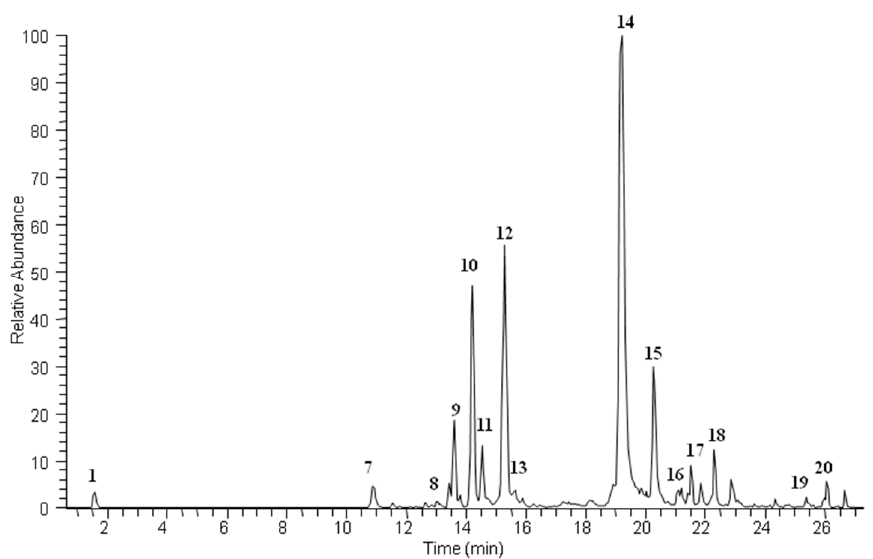
Figure 1. LC–MS profile in negative ion mode of Symphytum o ffi cinale ethanol Figure 1 . LC–MS profile in negative ion mode of Symphytum officinale ethanol extract .